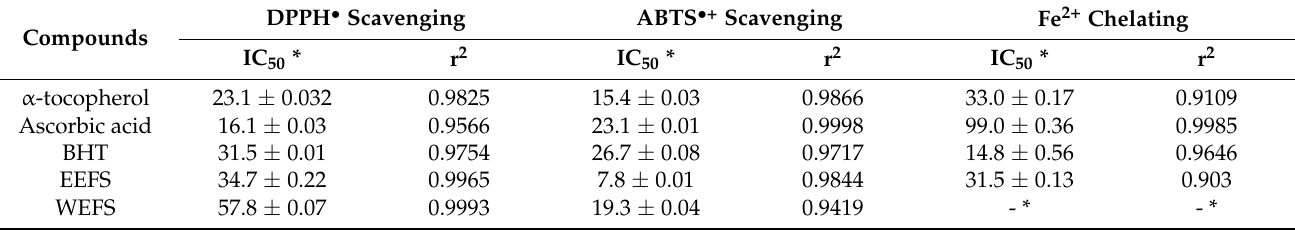
Table 2. The half maximum concentration (IC 50 , µ g/mL) of EEFS, WEFS, and standards for the DPPH and ABTS radicals scavenging activities and ferrous ion chelating ability (EEFS: evaporated ethanolic extract of aerial parts kınkor ( Ferulago stellata ); WEFS: lyophilized water extract of aerial parts of kınkor ( Ferulago stellata )). DPPH • Compounds